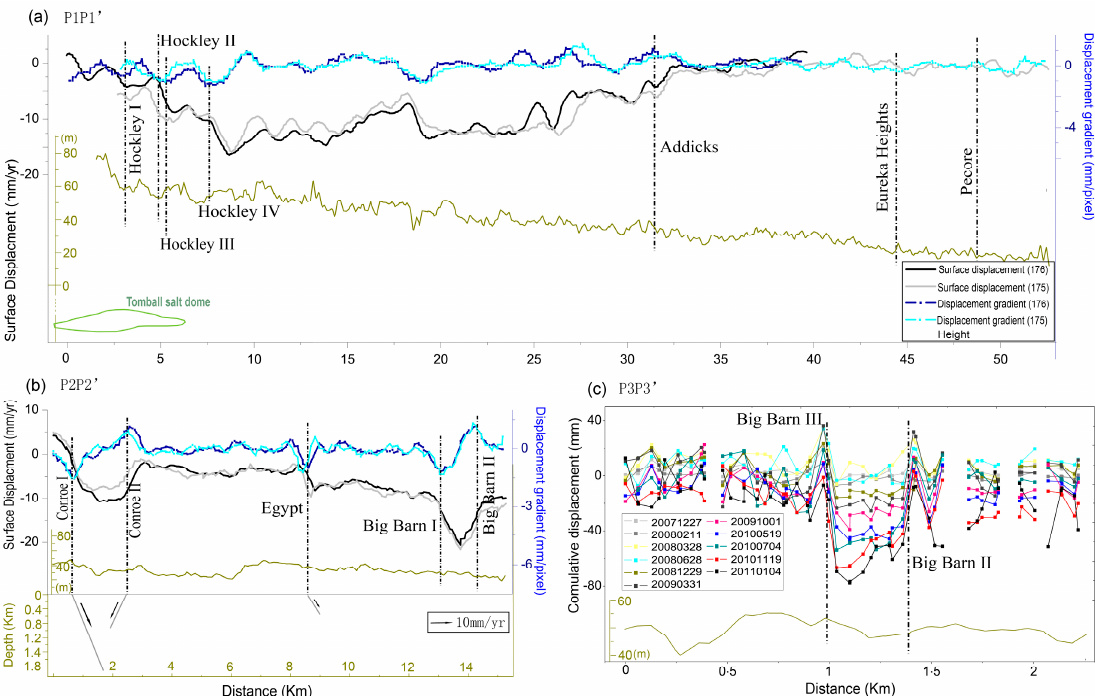
Figure 4. Annual ( a , b ) and time-series ( c ) subsidence result from interferometric synthetic aperture radar (InSAR) along three profiles whose positions are shown on Figure 3 as P#P#’. Dark yellow lines show the corresponding surface height. The rough sketch of some integrated faults’ geometry is shown at the bottom of ( b ). Green polygon in ( a ) shows approximate location of Tomball salt dome, whose underground depth is not clear. Dash lines represent fault locations.